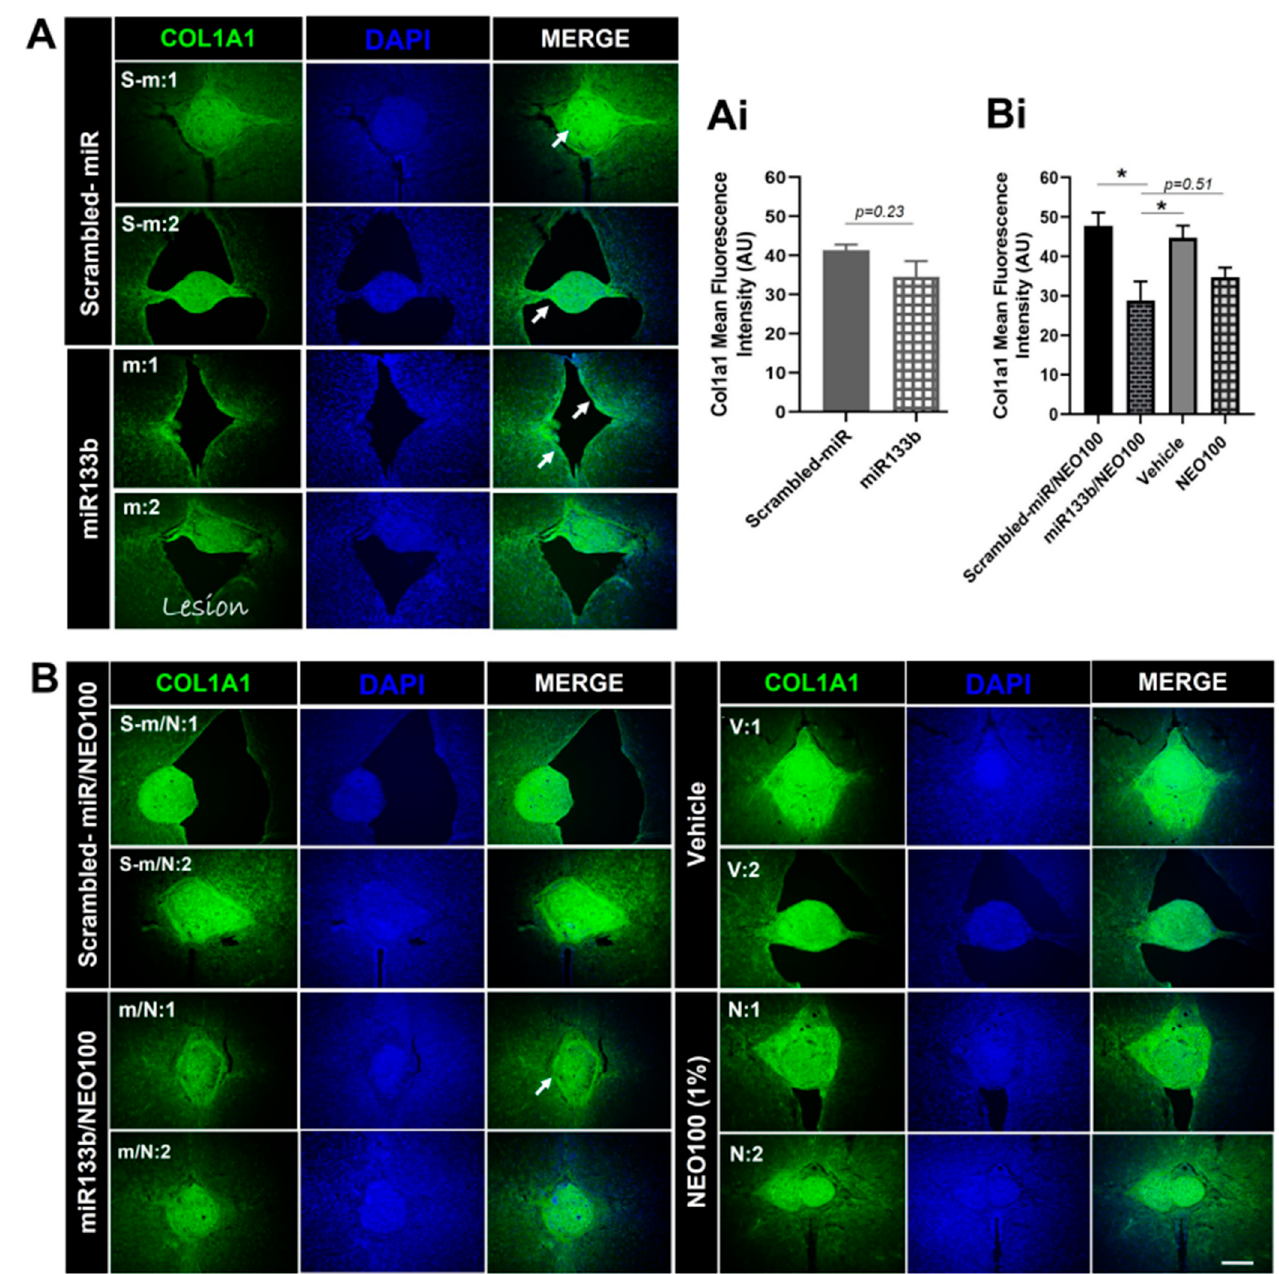
Figure 8. The e ff ect of intranasal delivery of miR133b/Ago2 either alone or in combination with 1% NEO100 on the Collagen 1 type 1 (Col1a1) protein expression at the lesion scar at 56 days post-injury. Panels ( A , B ) show representative images of the spinal cord sections immunolabeled with Col1a1. Sections were collected from two di ff erent mice per group, as follows: s − m:1 and s − m:2 from scram- bled-miR group; m:1 and m:2 from miR133b/Ago2 group; s − m/N:1 and s − m/N:2 from scrambled- miR/NEO100; m/N:1 and m/N:2 from miR133b/Ago2/NEO100 group; v:1 and v:2 from vehicle and N:1 and N:2 from NEO100 group. Panels ( Ai , Bi ) represent the fl uorescence quanti fi cation of Col1a1. T − test was employed for comparing the groups in graph ( Ai ). One − way ANOVA with Dunne tt ’s multiple comparison test was used for comparing the groups in graph ( Bi ). * p < 0.05; n = 4–5 sections per mouse, n = 3–5 mice per group. Note: The arrows indicate the Col1a1 expression at the lesion scar. Scale bar: 100 µm.